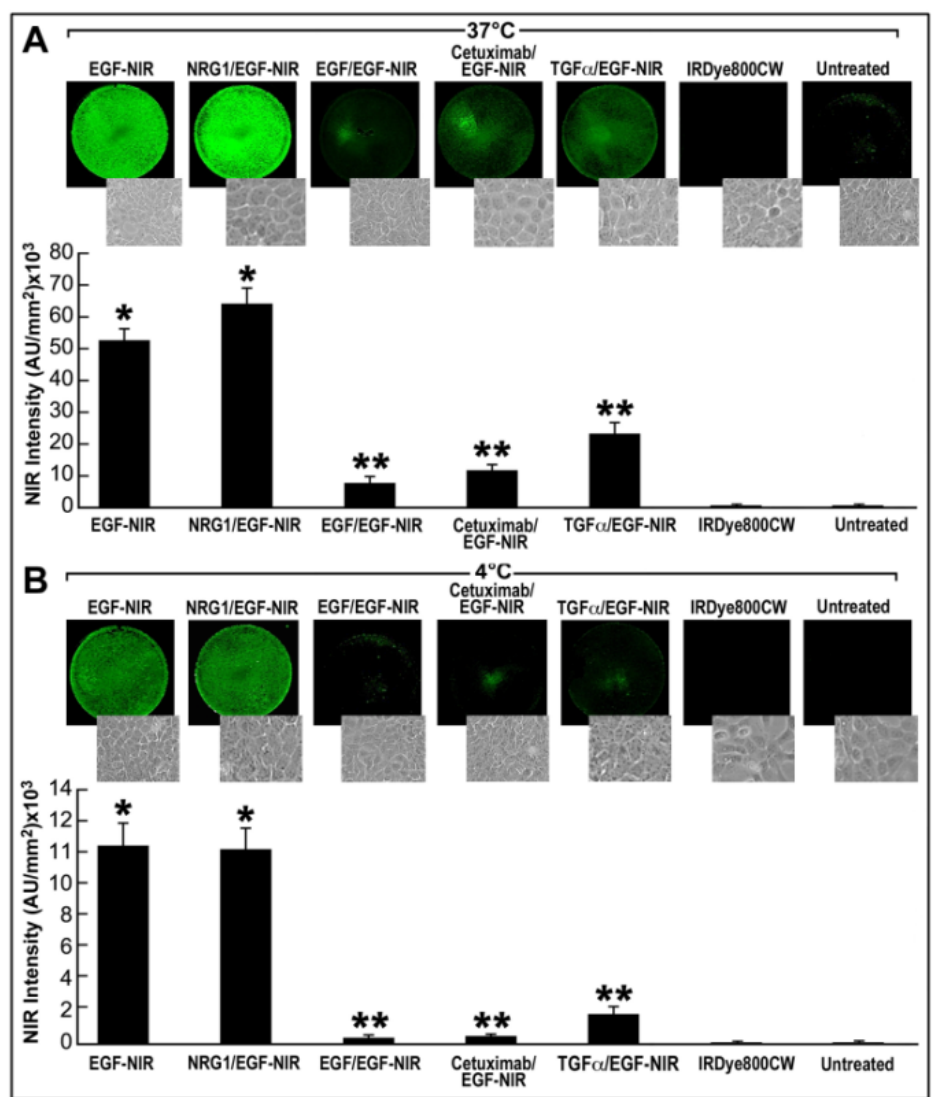
Figure 1. Specificity and selectivity of EGF-NIR probe measured by NIR bio-imaging of A431 cells; Monolayer of A431 cultures were incubated for 15 min at 4 °C ( A ) and 37 °C ( B ) with 7 nM EGF-NIR in the presence or absence of 100 nM unmodified EGF. Competition experiments with 500 nM of Cetuximab, TGF- α or NRG1 were also conducted. Nonspecific labeling of the cells was evaluated by incubating the cultures with 7 nM IRDye800CW. The NIR intensity was estimated (mean ± SD, n = 9) at the following conditions: resolution: 170–340 microns; pixel area: 0.03 mm 2 ; quality: medium-low; focus offset: 3; channels: 800 nm; intensity: 1; Upper inserts: NIR scans; lower inserts: phase-contrast photomicrographs of the cultures, * p < 0.05 vs. IRDye800CW, ** p < 0.05 vs.